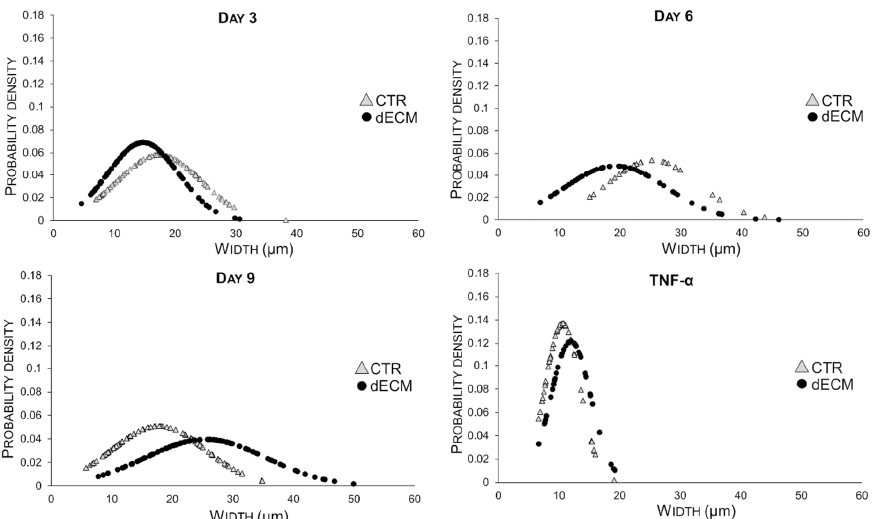
Figure 4. Time course of morphological changes (width) of C2C12 derived myotubes grown for 3, 6, and 9 days on plastic plates either uncoated or coated with dECM. The data are expressed as Gaussian curves with n ≥ 70. Measures were taken from bright filed images (20× magnification).